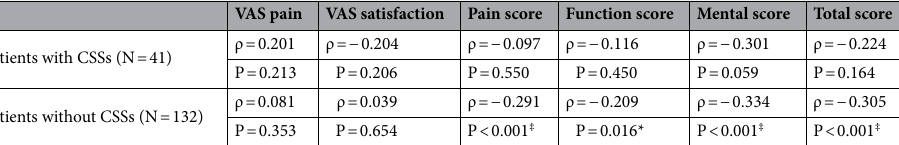
VAS pain VAS satisfaction Pain score Function score Mental score Total score ρ = 0.201 ρ = − 0.204 Patients with CSSs (N = 41)